Question: Looking at the figure, what chart type is it?
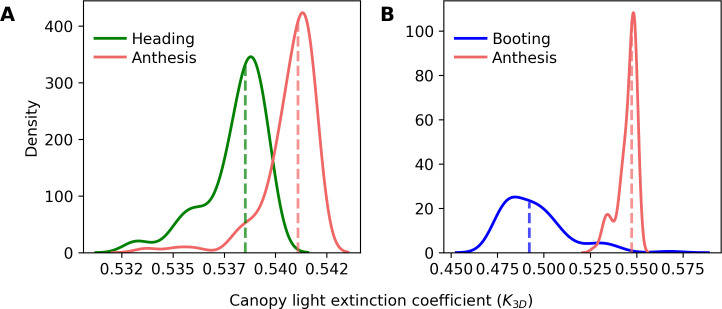
Answer: line